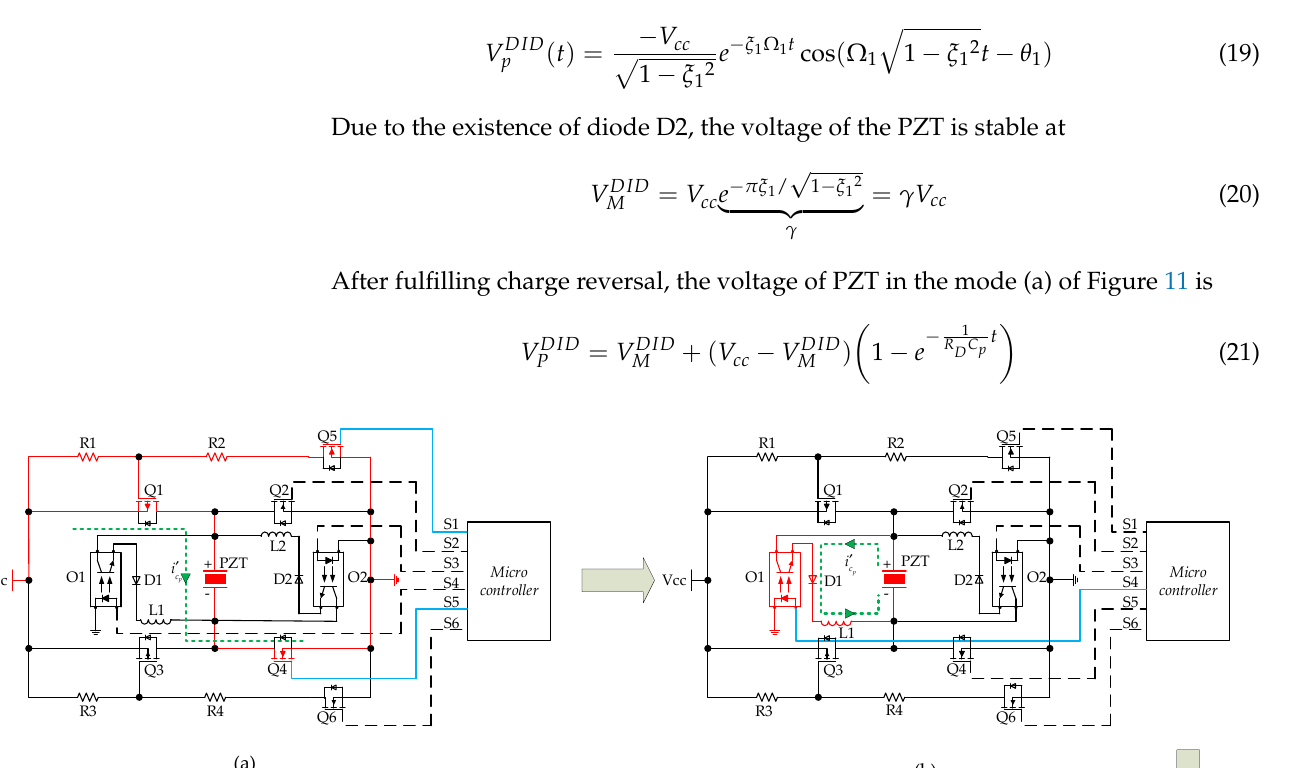
Figure 9. Double inductor-based driving (DID) circuit.